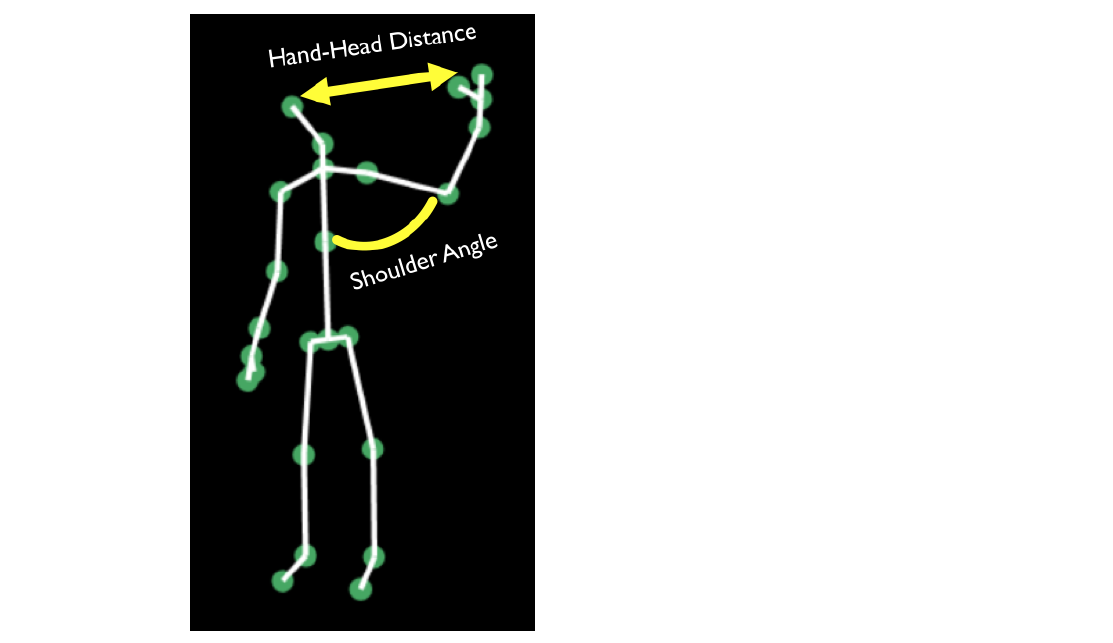
Figure 4. Spatio-temporal features are computed from the skeleton data in each recorded video